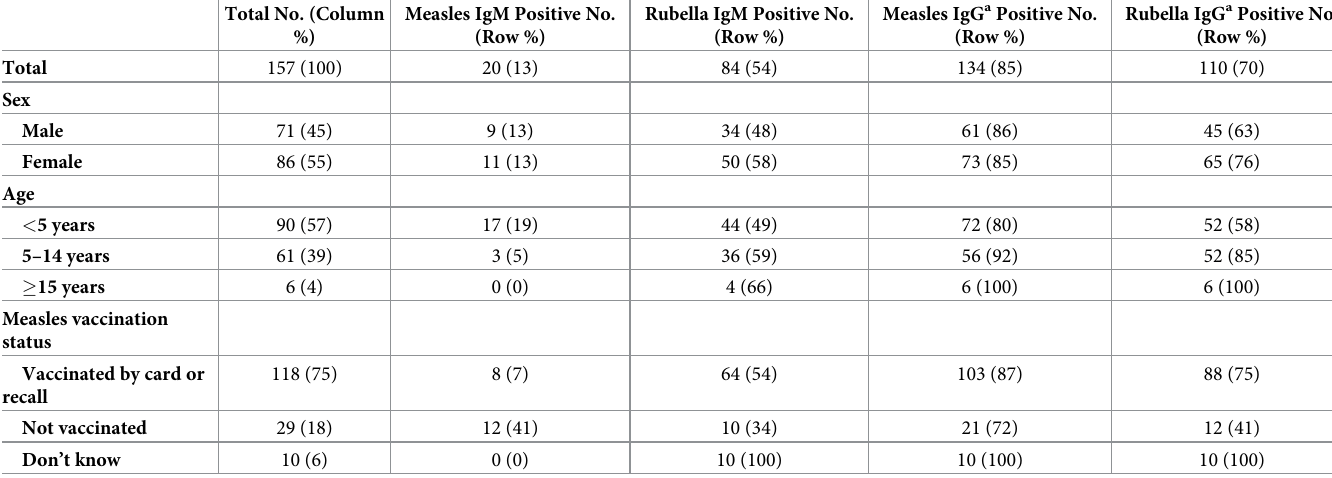
Table 1. Demographics, vaccination status, and measles and rubella IgM and IgG results among persons with suspected measles during an outbreak investigation, Kinshasa province, DRC, 2017. Total No. (Column